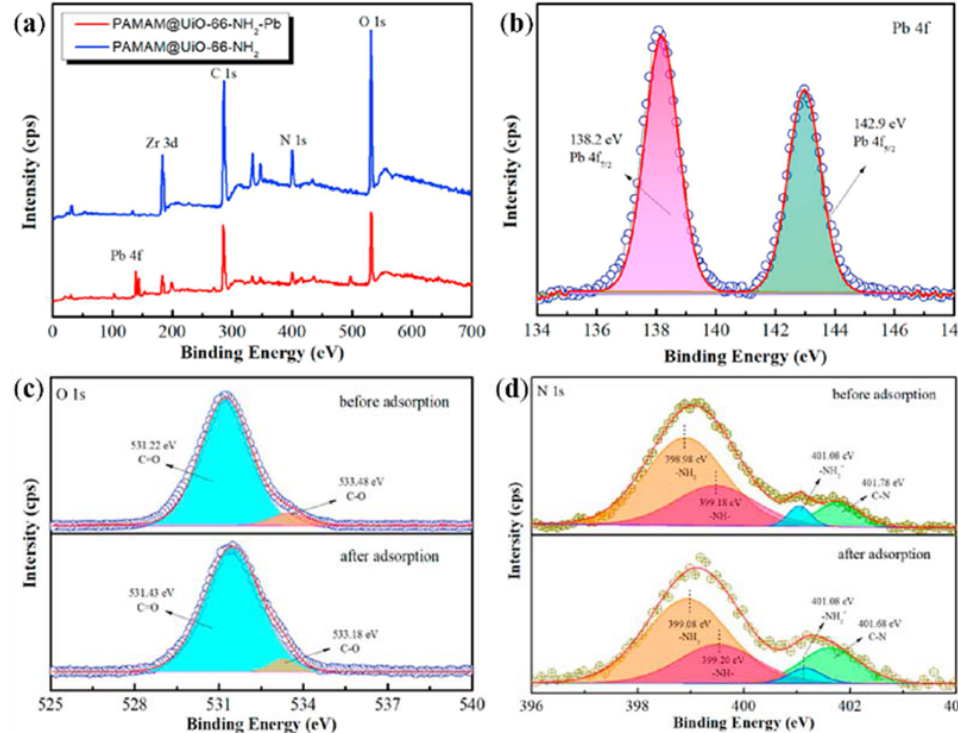
Figure 8. XPS total spectra ( a ), Pb 4f after adsorption ( b ), N 1s before adsorption and after adsorption ( c ), O 1s before adsorption and after adsorption ( d ). Reprinted with permission from Ref. [103]. 2021, Elsevier.